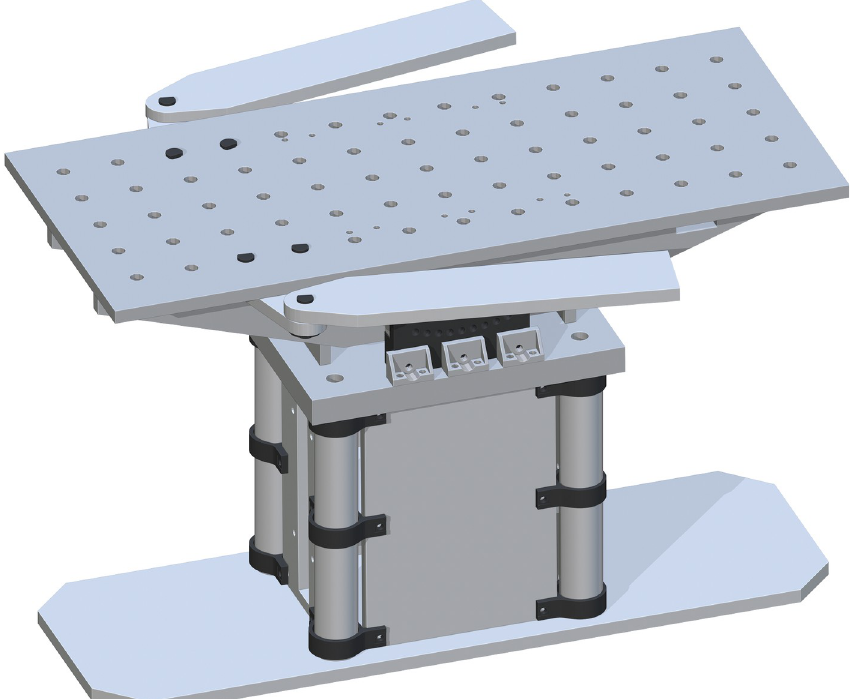
Fig 15. Final two arm-rest_mounting_pin holding Arm Rests in